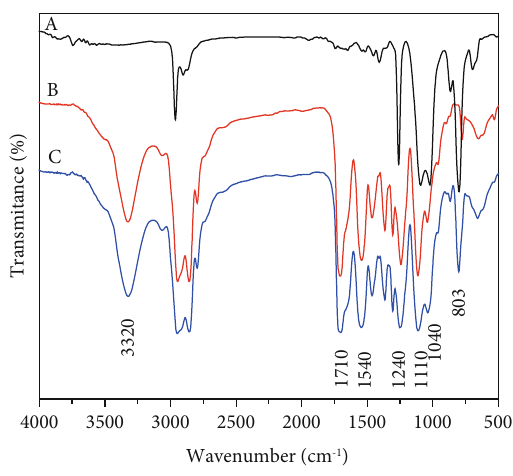
Figure 3: FTIR spectra: (a) LEPS, (b) WPU0, and (c) WPU4. Table 2: E ff ect of LEPS content on properties of WPU emulsion.